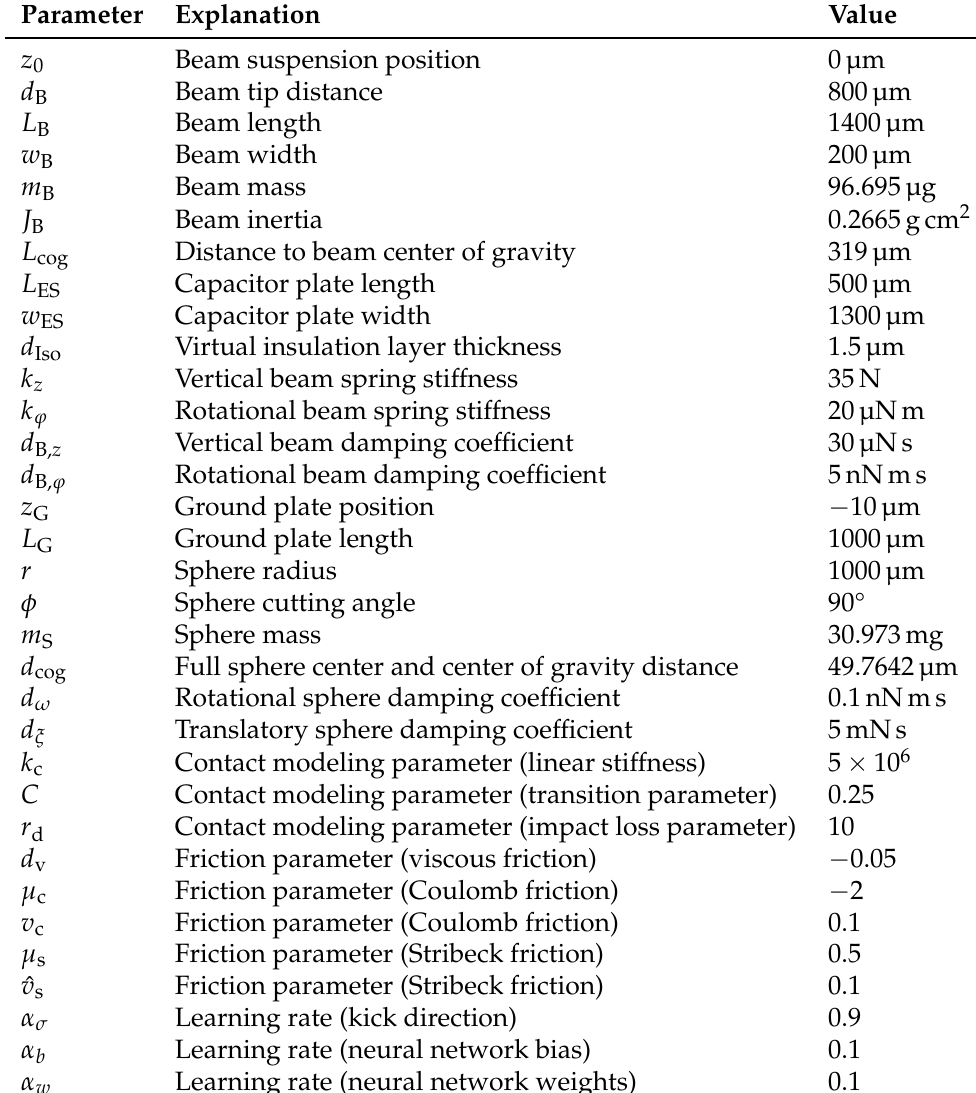
Table A1. Design and simulation parameters used throughout the